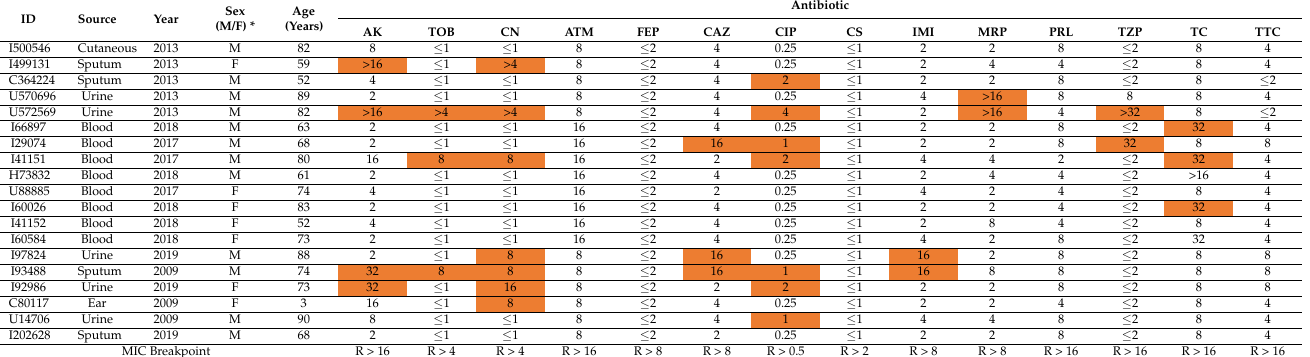
Table 1. Antibiogram of P. aeruginosa clinical isolates used for assessing the lytic spectrum of phages.